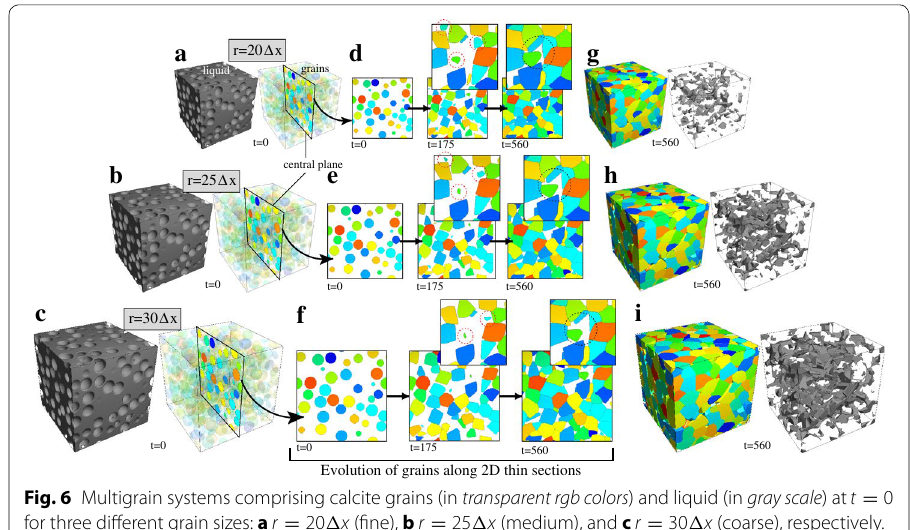
Fig. 6 Multigrain systems comprising calcite grains (in transparent rgb colors ) and liquid (in gray scale ) at t = 0 for three different grain sizes: a r = 20 (cid:31) x (fine), b r = 25 (cid:31) x (medium), and c r = 30 (cid:31) x (coarse), respectively. Central planes of the three simulation domains are chosen for visualization. d – f Evolution of grains along the central plane for different initial grain sizes. The zoomed outlet pictures depict the varying sizes of grains (in red dotted circles ) at t = 175 and the varying amount of pore space (in black dotted circles ) at t = 350 for differ- ent grain sizes. Colors are used to distinguish between different grains. g – i Numerically cemented microstruc- tures along with liquid at t = 560 for different grain sizes. The reduction in liquid volume is observed to